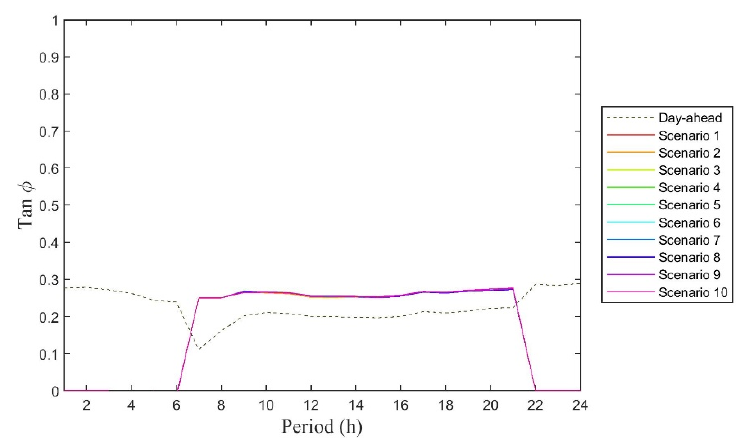
Figure 5. Forecasted and realized tan ϕ at the main substation throughout 24 hours.